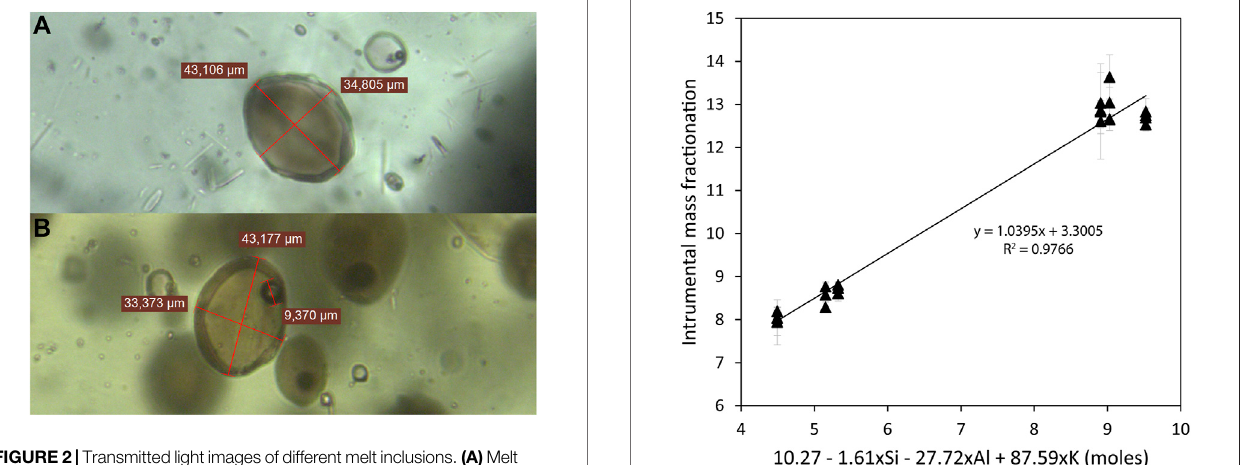
FIGURE2| Transmittedlightimagesofdifferentmeltinclusions. (A) Melt inclusion in olivine N1, with no bubble inside. (B) Several melt inclusions, all containing a bubble, in olivine